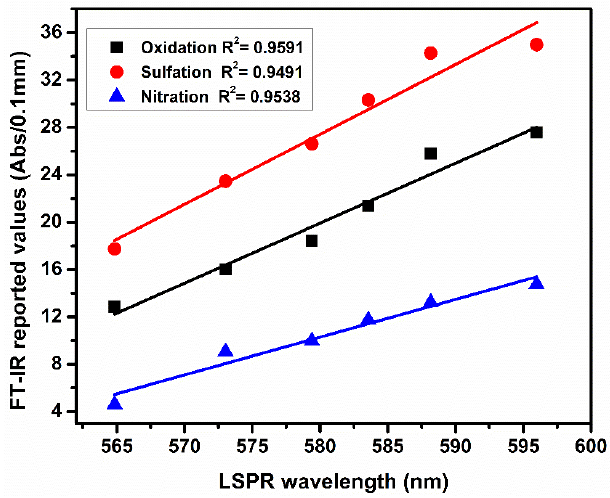
Figure 10. Correlation between FT-IR and LSPR wavelength, colored lines represent linear fittings of the experimental data.